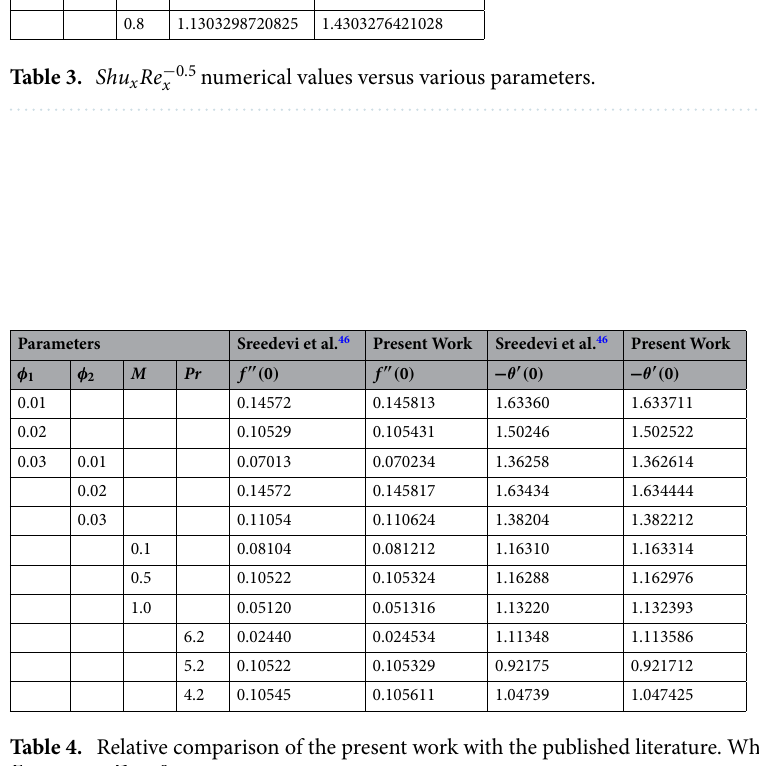
Table 4. Relative comparison of the present work with the published literature. While keeping E 1 = σ 1 = Ŵ = 0.